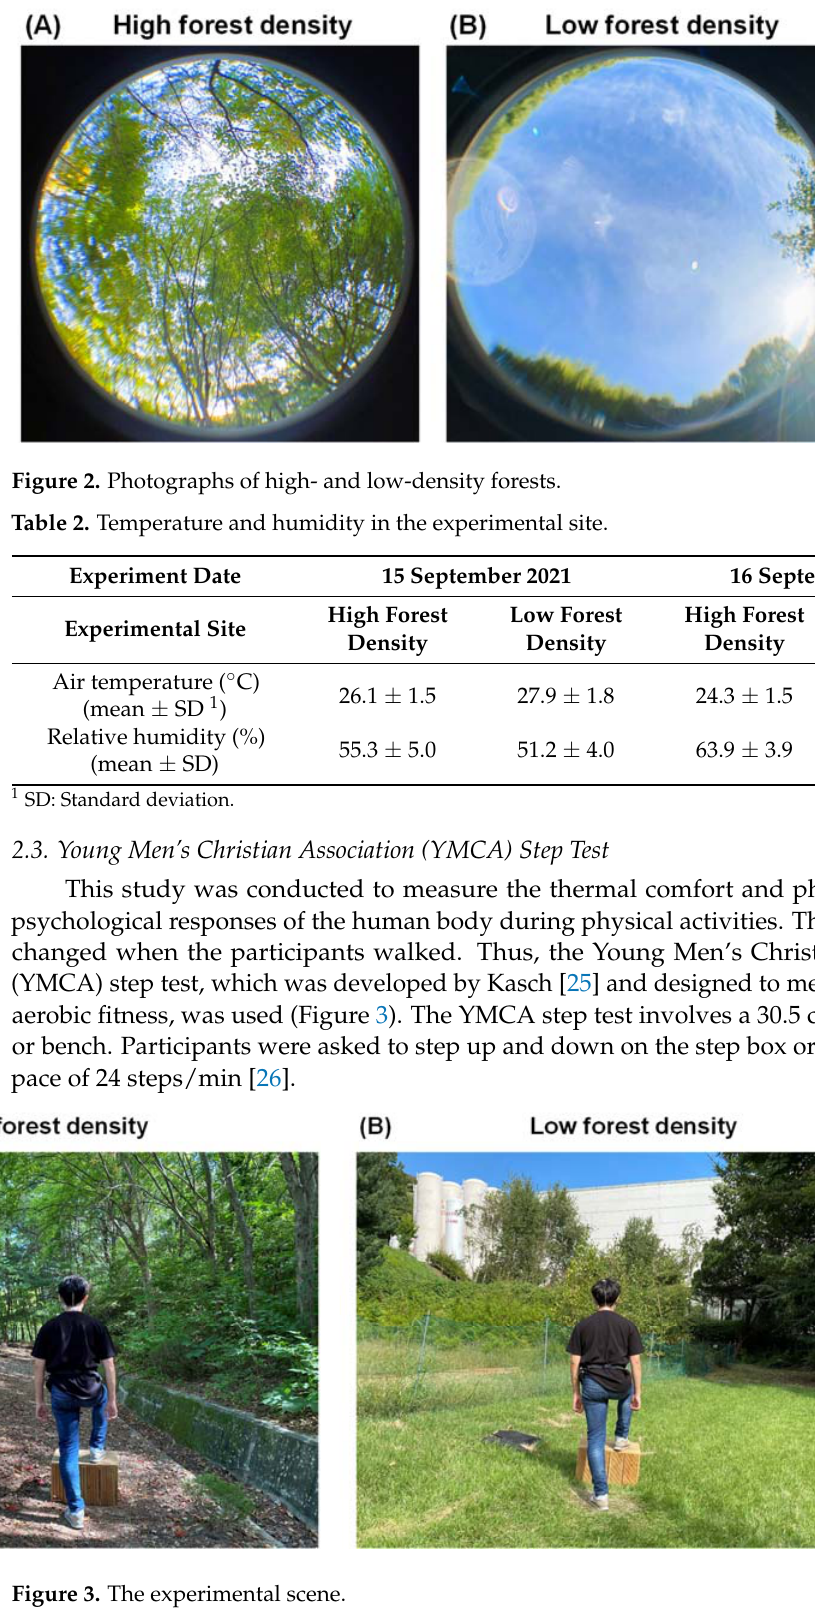
Figure 1. The location of the two experimental sites.